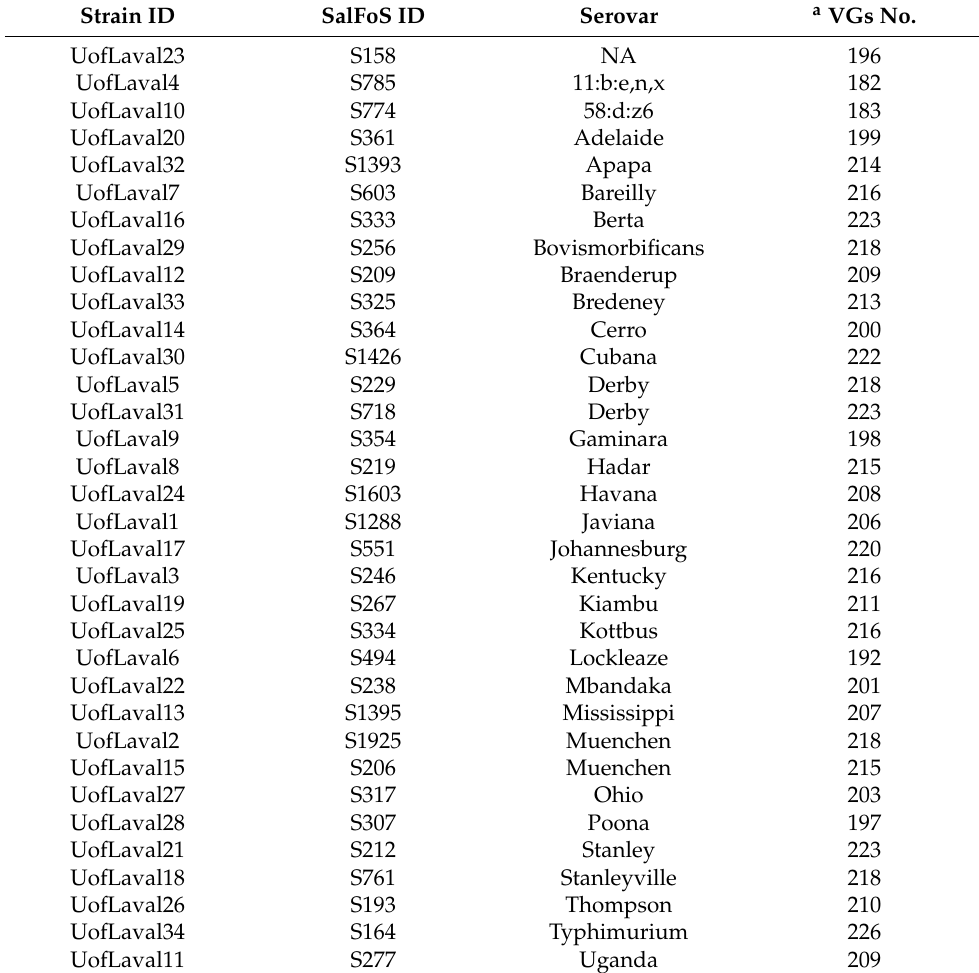
Table 5. Validation of AmpliSeq Salm_227VG based on blind assessment of virulence and serovar designation for 34 Salmonella